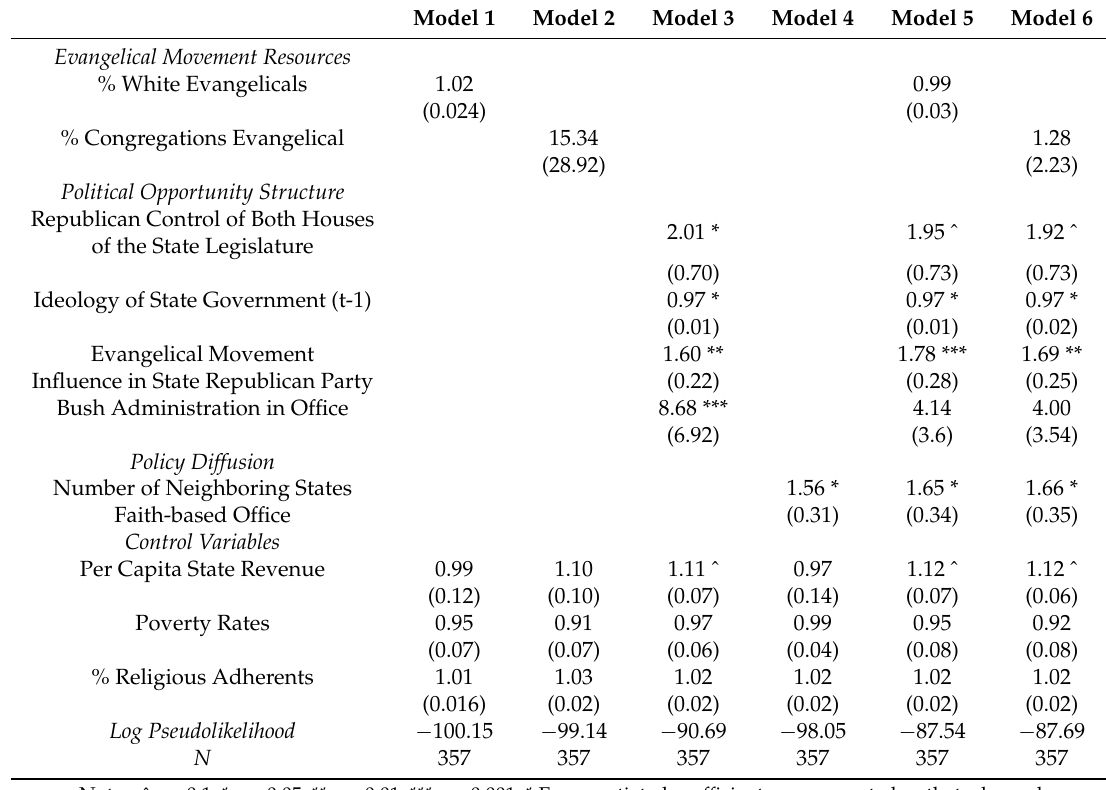
Table 3. Event History Analysis of State Creation of a Faith-Based Liaison Position and/or Office of Faith-Based Community Initiatives: 1998–2007